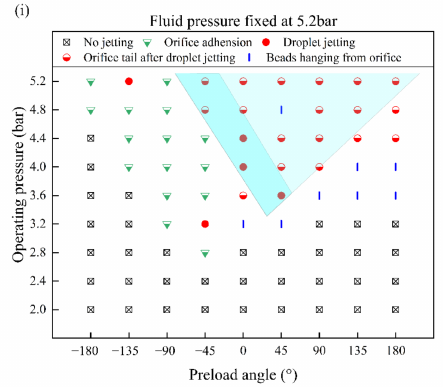
Figure 4. Jetting states under different preloading angles and operating pressures with the fluid pressure fixed at values of ( a ) 2.0 bar, ( b ) 2.4 bar, ( c ) 2.8 bar, ( d ) 3.2 bar, ( e ) 3.6 bar, ( f ) 4.0 bar, ( g ) 4.4 bar, ( h ) 4.8 bar, and ( i ) 5.2